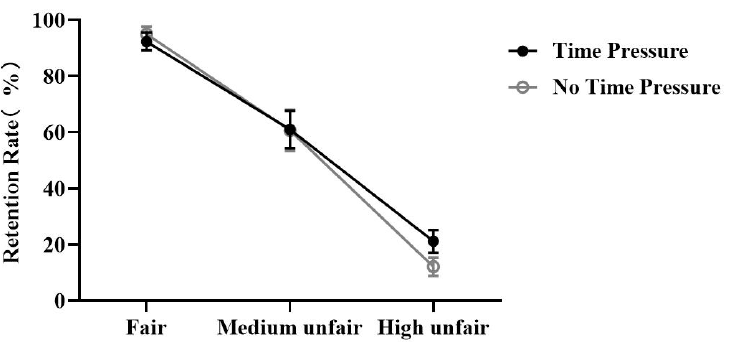
Figure 3. Line graph of retention rates for different offers under time pressure and no time pressure conditions (mean ± se).